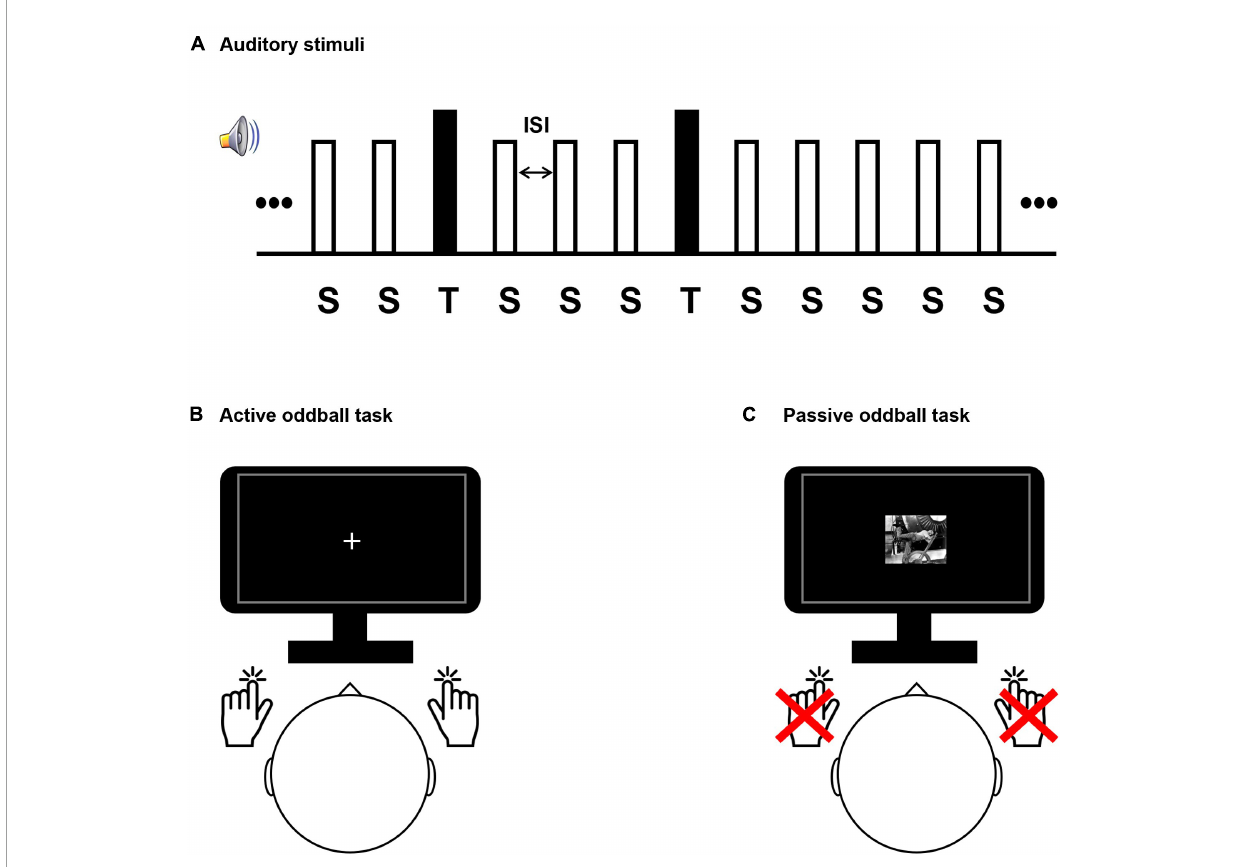
FIGURE1 Experimental design. (A) The auditory stimulus presentation sequence comprised a series of frequent standard “S” stimuli (80% occurrence probability; 500 Hz tones) and rare target “T” stimuli (20% occurrence probability; 8 kHz tones for healthy subjects and individual tinnitus pitch-matched frequencies for patients). Stimuli were presented for 200 ms and had variable interstimulus interval (1,300–1,700 ms). Participant conducted a sound discrimination task in the active oddball task (B) , and passively watched a silent movie in the passive oddball task (C)